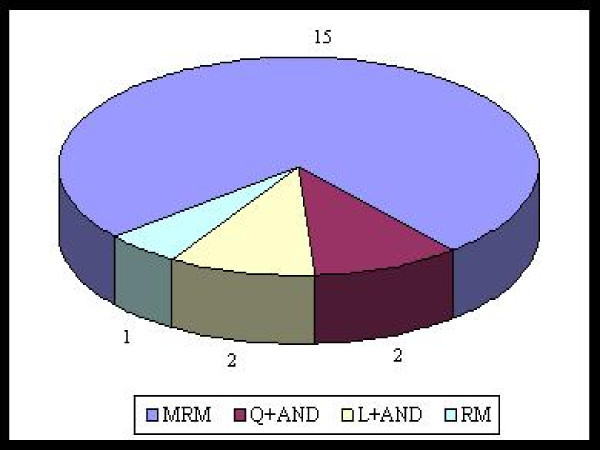
Distribution of patients according to the operation type. MRM: Modified radical mastectomy, Q+AND: Quadranectomy + axillary node dissection, L+AND: Lumpectomy + axillary node dissection, RM: Radical mastectomy.